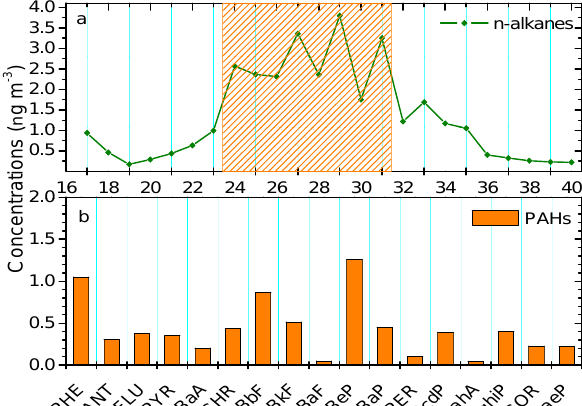
Fig. 4. The average concentrations for each n -alkane species (a) and each PAH species (b) in PM 2 . 5